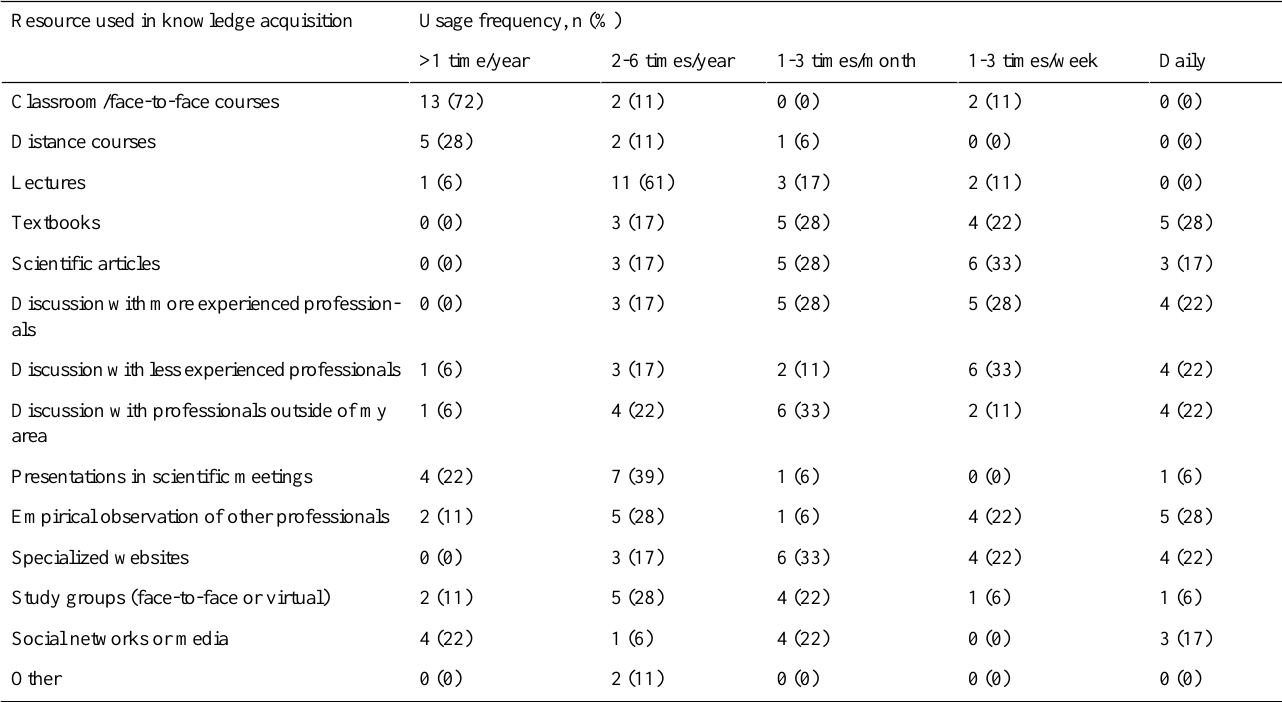
Table 5. Sources of participants’knowledge acquisition